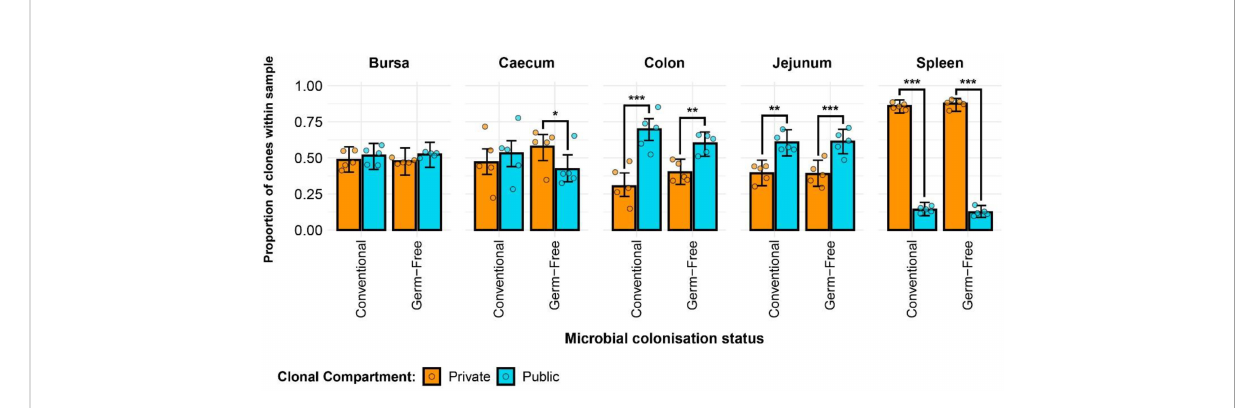
FIGURE 4 TCR b clone CDR3 nucleotide public and private compartments. Private (individual-restricted) clones are shown in orange. Public clones (shared between more than two individuals) and are shown in light blue. Dots represent individual bird observations of public and private clonal compartments. Error bars represent 95% bootstrap con fi dence intervals for the point estimates generated from 1000 simulations of the model. Statistically signi fi cant differences between the model estimates are depicted above the plots based on their corresponding p-values: *p < 0.05; **p < 0.01, ***p <